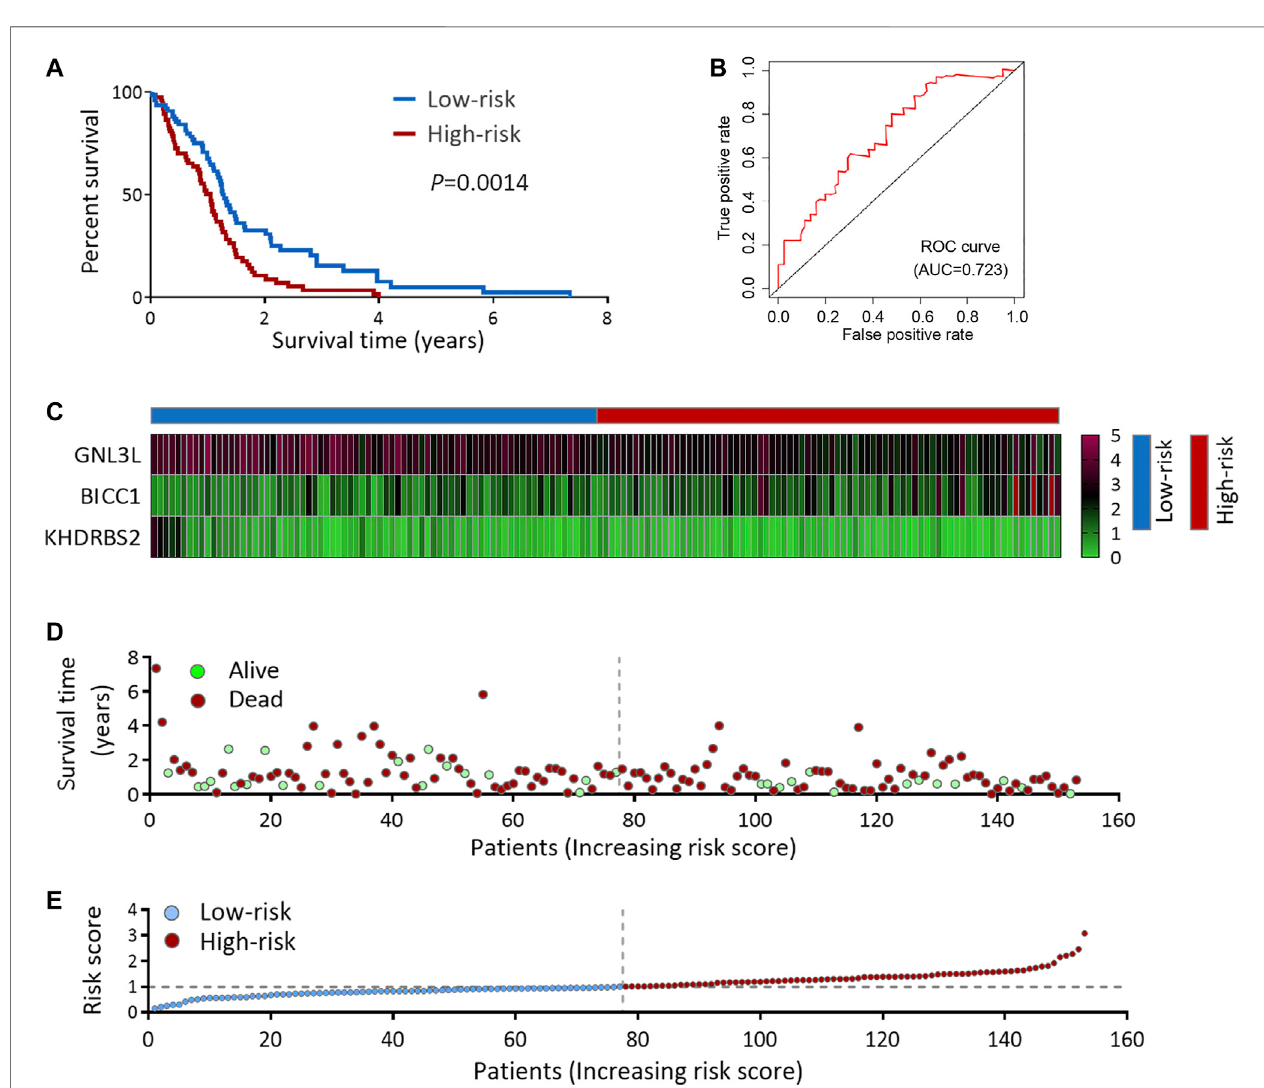
FIGURE 4 | Risk score analysis of 3-genes prognostic model in TCGA cohort. (A) OS analysis among TCGA GBM patients strati fi ed by risk score. (B) ROC curve for forecasting OSbased on riskscore. (C) Expression heatmap ofthe 3 hubRBPs. (D) Survivalstatus ofthe TCGA GBM patients. (E) The riskscorevalues in low- and high-risk subgroups. OS, overall survival.